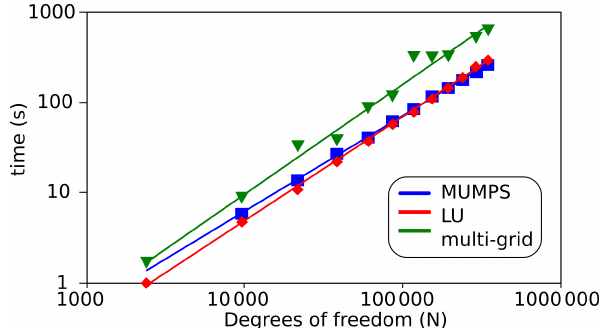
Figure 6. Computation time for Experiment B plotted vs. the degrees of freedom and using different solvers. Blue: Mumps (0 . 00037 N 1 . 06 ). Red: LU (0 . 00013 N 1 . 15 ). Green: multi-grid (0 . 00014 N 1 . 212